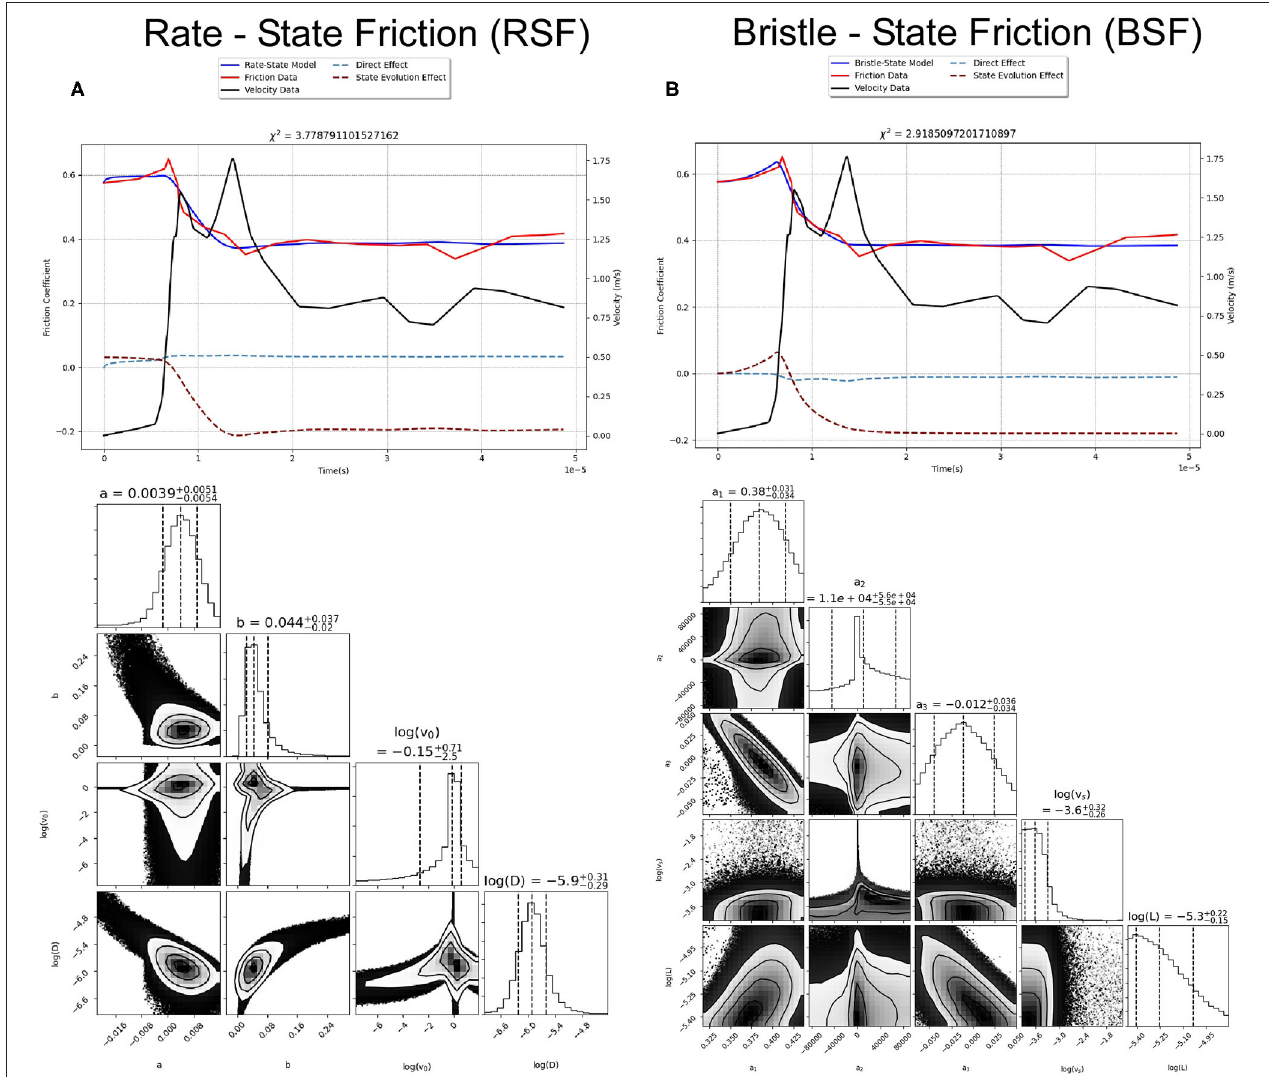
FIGURE 4 | Best-fits of (A) RSF and (B) BSF models to spontaneously developing slip experiment at 5.66 MPa normal stress from Rubino et al. (2017), details are the same as for Figure 3